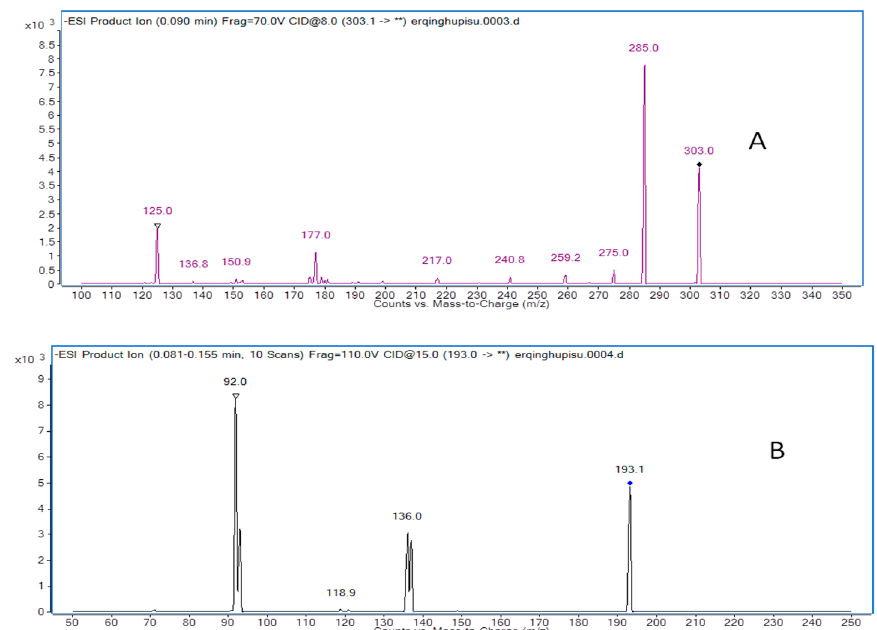
Table 5. Optimized mass spectrometric parameters for the LC/MS analysis of taxifolin and butylparaben in MRM mode.